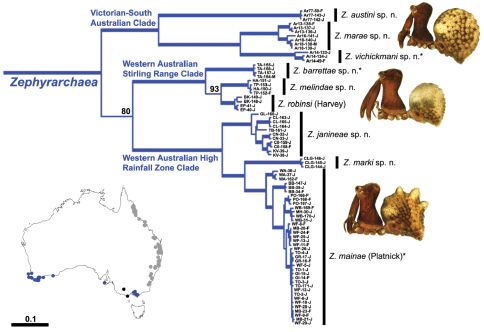
Phylogeny of Zephyrarchaea species from Rix and Harvey (2012), showing results from a combined, gene-partitioned Bayesian analysis of that study’s multi-gene dataset (2591 bp: COI, COII, tRNA-K, tRNA-D, ATP8, ATP6, H3). Clades with >95% posterior probability support are denoted by thickened branches, with lower individual clade support values shown above nodes. Note the presence of three main regional clades, each illustrated with an exemplar species (highlighted*). The Victorian species Zephyrarchaea grayi sp. n. and Zephyrarchaea porchi sp. n. were not able to be sequenced for this study (shown as black dots on inset map).